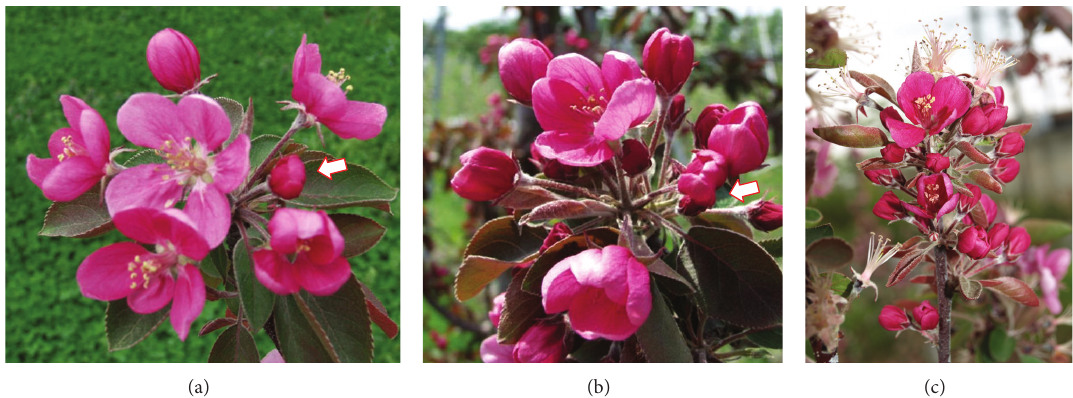
Figure2: (a)A“Maypole”flower cluster having two central flowers. Onecentral flower fullyopened, buttheotheronedidnotopen (indicated by arrow). (b) Flower of